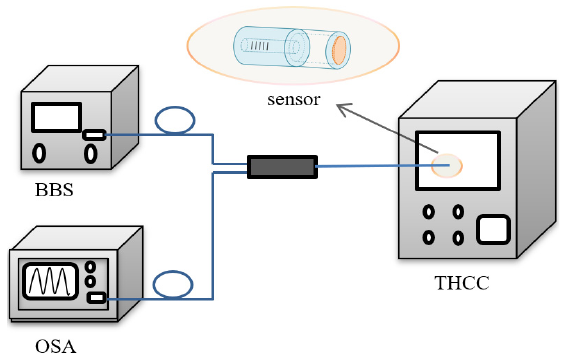
Figure 2. Experimental setup of the measuring system.